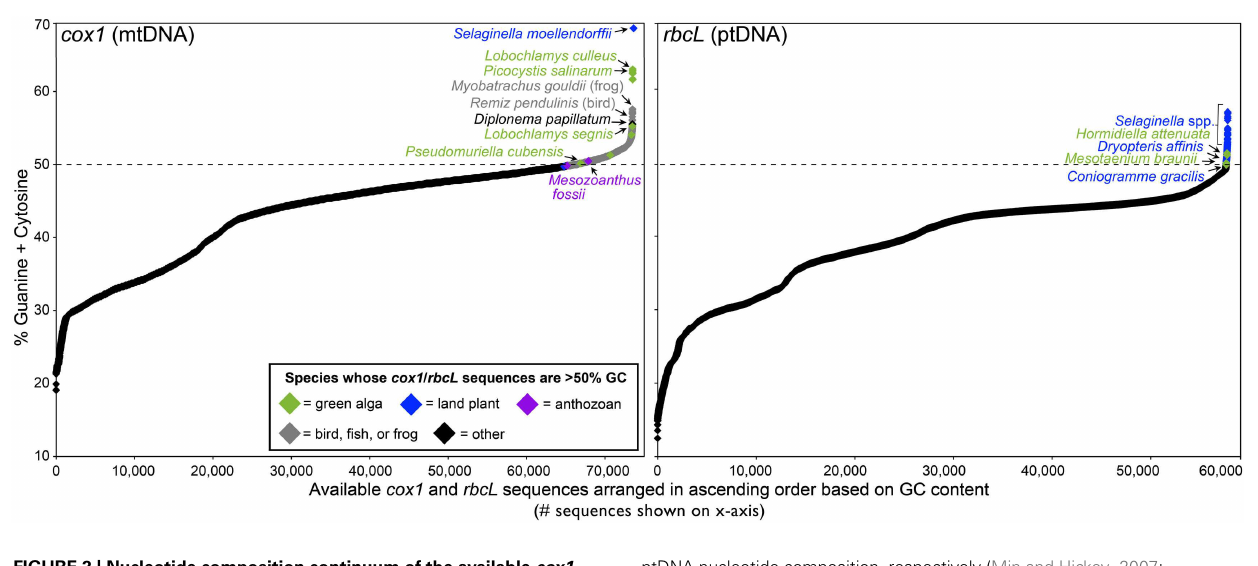
ptDNA nucleotide composition, respectively (Min and Hickey, 2007; Smith, 2009). Complete and partial cox1 and rbcL sequences (minimum length = 400 nt) were downloaded from GenBank on January 1, 2012. Given the huge number of bilaterian cox1 sequences ( > 300,000), the chart only shows those for species from the Actinopterygii, Archosauria, and Amphibia – the bilaterians known to have cox1 sequences that can exceed 50%